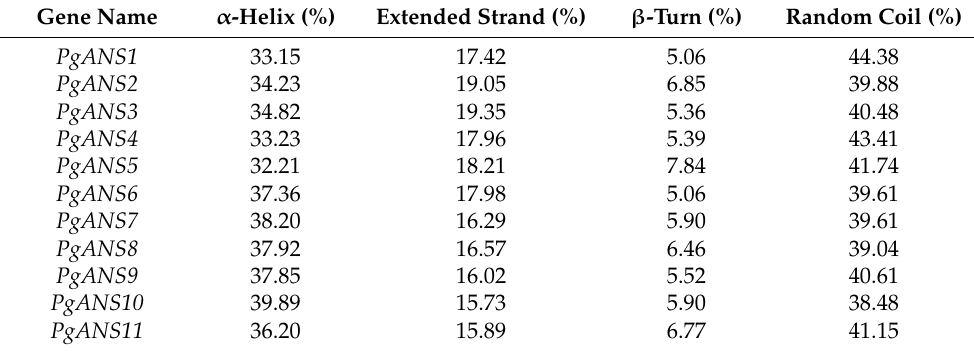
Table 2. Predicted secondary structure of the pomegranate ANS gene family